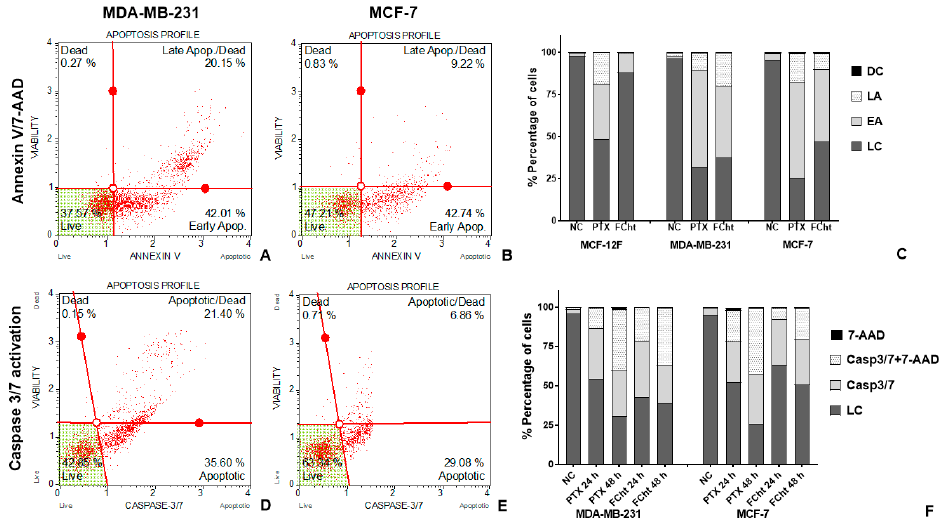
Figure 3. Apoptosis induction on BC cells. The dots (in red) represent a single cell analyzed, and dots in the green area correspond to live cells. ( A ) Annexin V/7-AAD detection on MDA-MB-231 cells exposed to Tacotanina, and ( B ) On MCF-7 cells. ( C ) Percentage of live cells (LC), cells in early apoptosis (EA), late apoptosis (LA), and non-apoptotic dead cells or nuclear debris (DC) after treat- ment with paclitaxel (PTX) or flavanone (Tacotanina) on MCF-12F, MDA-MB-231 and MCF-7 cells; NC corresponds to non-treated cells ( D ) Dot plot of Caspases 3/7 activation upon treatment with Tacotanina on MDA-MB-231 cells and ( E ) on MCF-7 cells. ( F ) Percentage of live cells (LC), early apoptotic cells with Casp3/7 activated, apoptotic cells with both Casp3/7 and 7-AAD detection, and non-apoptotic dead cells stained with 7-AAD after treatment with PTX or Tacotanina on MDA-MB- 231 and MCF-7 cells; NC correspond to non-treated cells. Microtubules and nuclei of MDA-MB-231 cells were evaluated by epifluorescence microscopy after treatment with PTX and Tacotanina. It was observed that the positive control PTX, a recognized microtubule damage agent, caused the disruption of microtu- bule dynamics as part of the mechanism of inhibition of cell proliferation and subsequent apoptosis, characterized by the condensation of nuclei and the apparent formation of apoptotic bodies (Figure 4). Similarly, treatment of TNBC cells with Tacotanina, at the IC 50 value for 24 h, results in impaired microtubule integrity (white rows, Figure 4) and nuclei condensation (red rows, Figure 4).